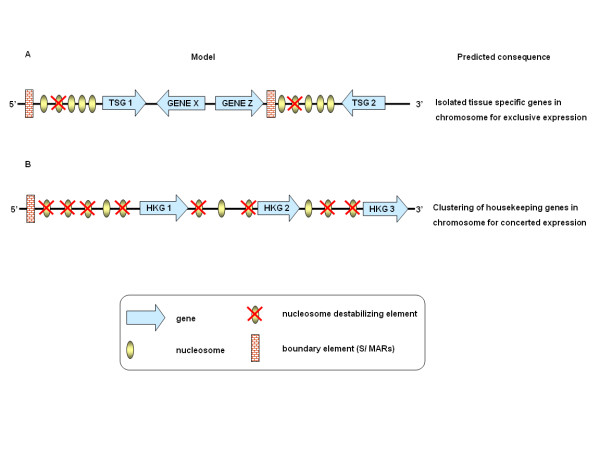
A model for chromatin landscape in 5' regions of tissue specific and housekeeping genes. (A) depicts the repressive role of chromatin in maintaining tissue specific gene expression profiles in a chromosome. The chromatin organisation in the 5' regions of Tsg1 and Tsg2, two different tissue specific genes dispersed in the chromosome is shown. Nucleosome formation potentials and S/MARs – the boundary elements, are enriched in their upstream regions and might play a major role in facilitating tissue specific expression. This is likely to be a local effect since neighbouring genes might have a different expression pattern. (B) depicts the chromatin organisation in the 5' regions of Hkg1, Hkg2 and Hkg3, three housekeeping genes clustered in the chromosome. The presence of low nucleosome formation potential regions and enrichment of nucleosome destabilising elements ensure an open chromatin configuration in this domain. As Hkg generally cluster together, they are depleted in S/MARs relative to tissue specific genes as shown in the present analysis by the significant absence of predicted S/MARs in both 5' and 3' regions of housekeeping genes as compared to tissue specific genes.